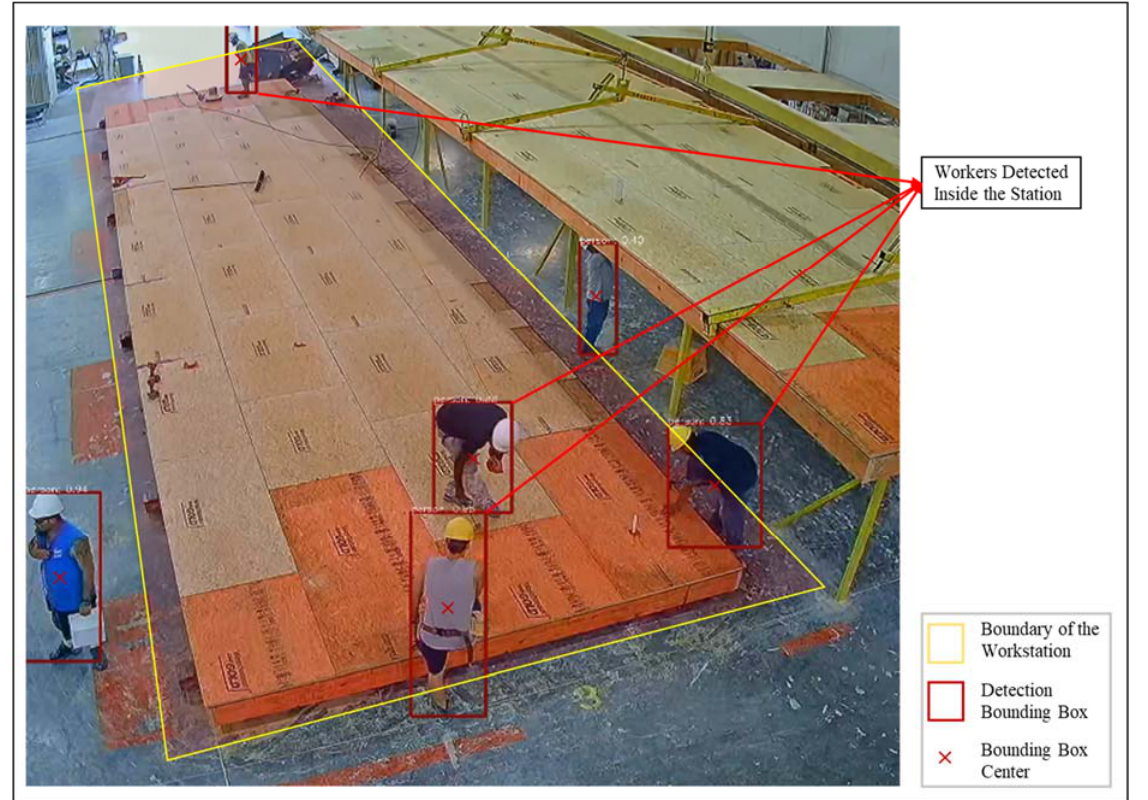
Figure 18. Workers detected inside the workstation in a sample video frame.